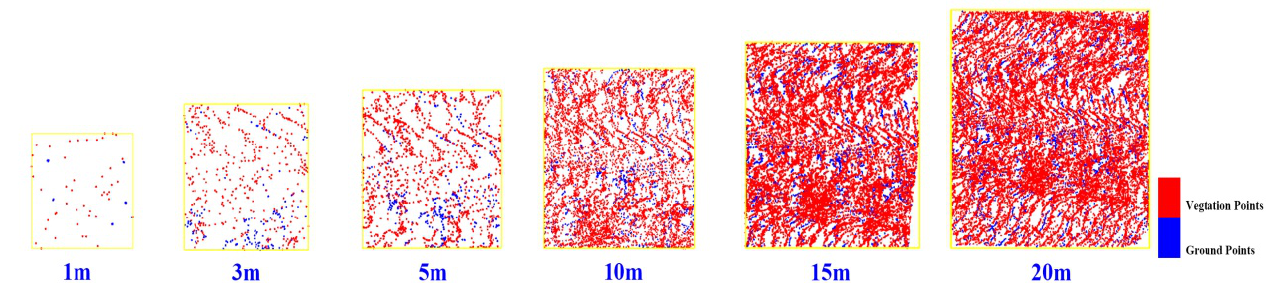
Figure 8. Distribution of vegetation points and ground points in different grid sizes. The statistical variables, standard deviations, correlation coefficients, and RMSDs were calculated between the LAIe values that were extracted by UAV-LS and the measured LAIe values, and the best grid was selected from the 3, 5, 10, 15, and 20 m resolutions based on the absolute distance to the reference point (Ref) at different resolutions. Based on this analysis, a resolution of 15 m yielded the best result (Figure 9).